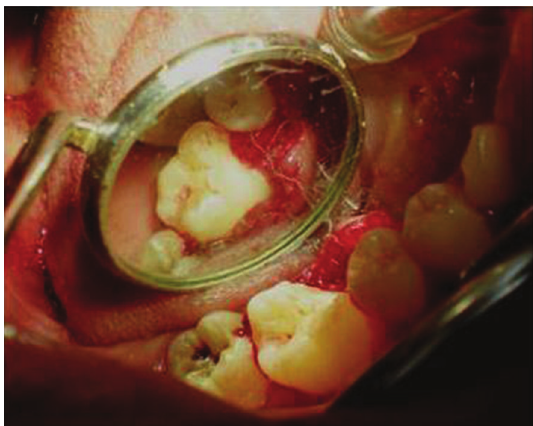
Figure 13: Lingual view of reflected full thickness mucoperiosteal flap and surgical correction of biologic width with 46.